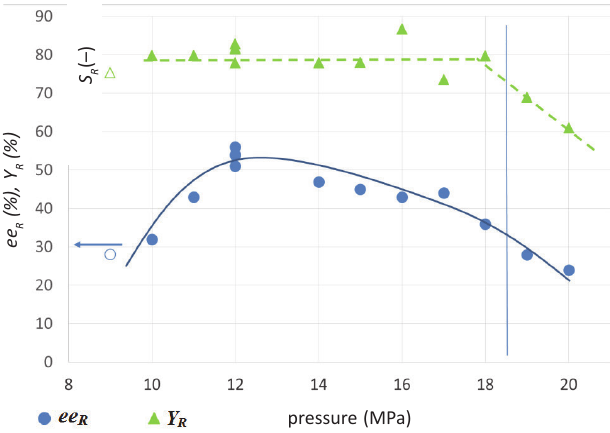
Fig. 6 – Effect of pressure on diastereomeric salt formation. Fig. 6 Effect of pressure on diastereomeric salt formation. Reaction conditions: 0.5 molar ratio at 40 °C Reaction conditions: 0.5 molar ratio at 40 °C for 1 h. Empty Fig. 6 Effect of pressure on diastereomeric salt formation. Reaction conditions: 0.5 molar ratio at 40 °C symbols indicate wet raffinates. The lines are to guide the eye. Fig. 6 Effect of pressure on diastereomeric salt formation. Reaction conditions: 0.5 molar ratio at 40 °C for 1 h. Empty symbols indicate wet raffinates. The lines are to guide the eye. for 1 h. Empty symbols indicate wet raffinates. The lines are to guide the for 1 h. Empty symbols indicate wet raffinates. The lines are to guide the eye. 191